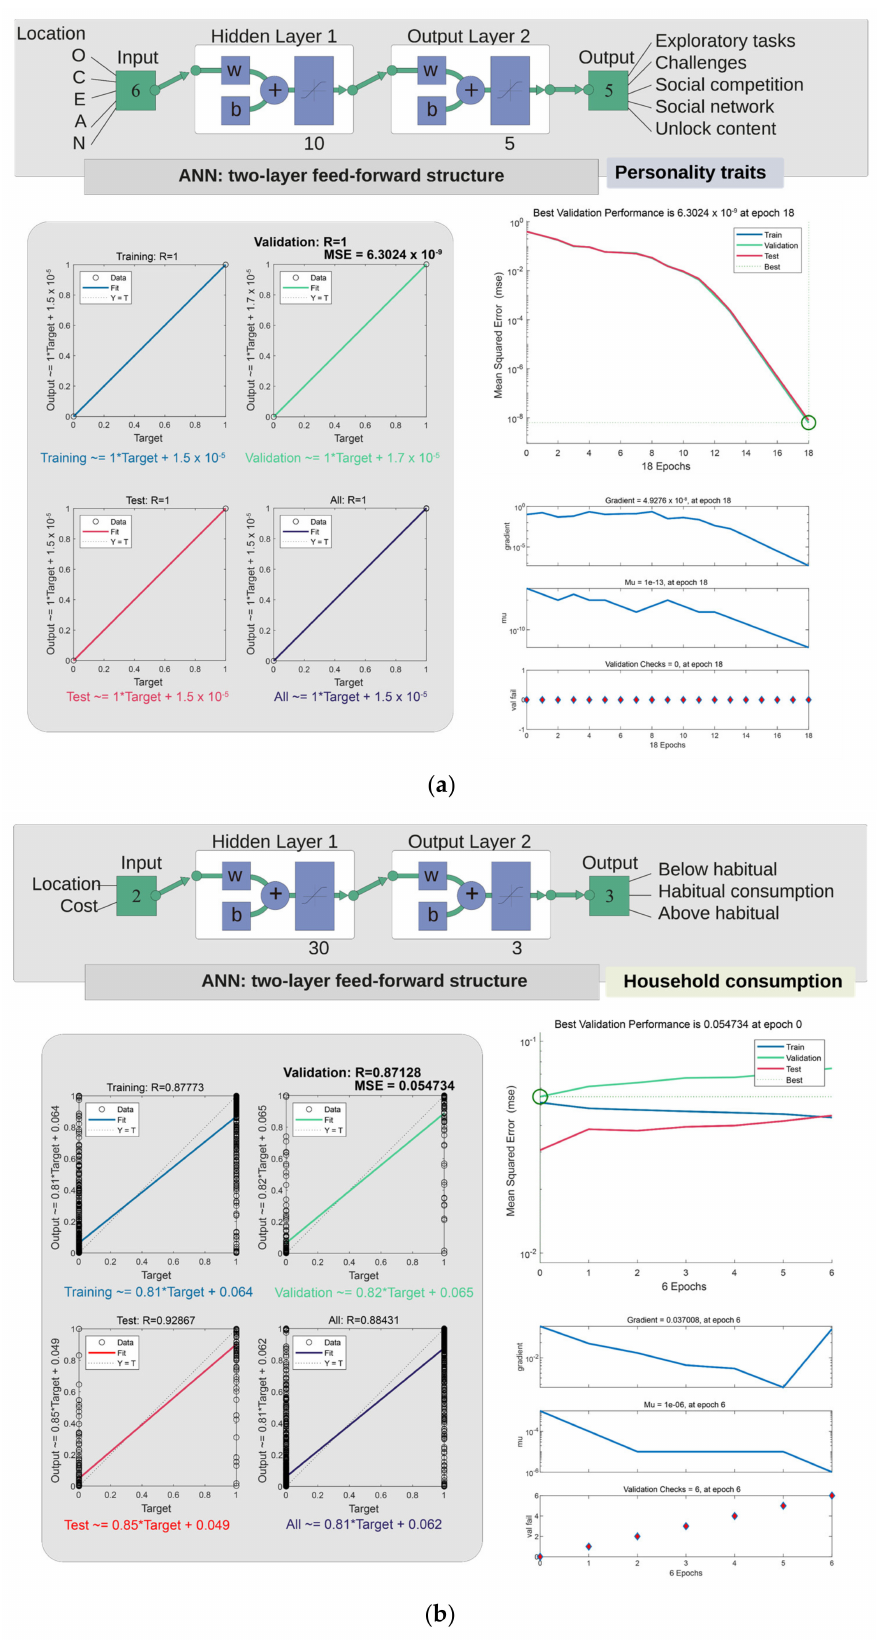
Figure 9. ANNs: ( a ) First ANN for the personality traits and ( b ) second ANN for the electricity